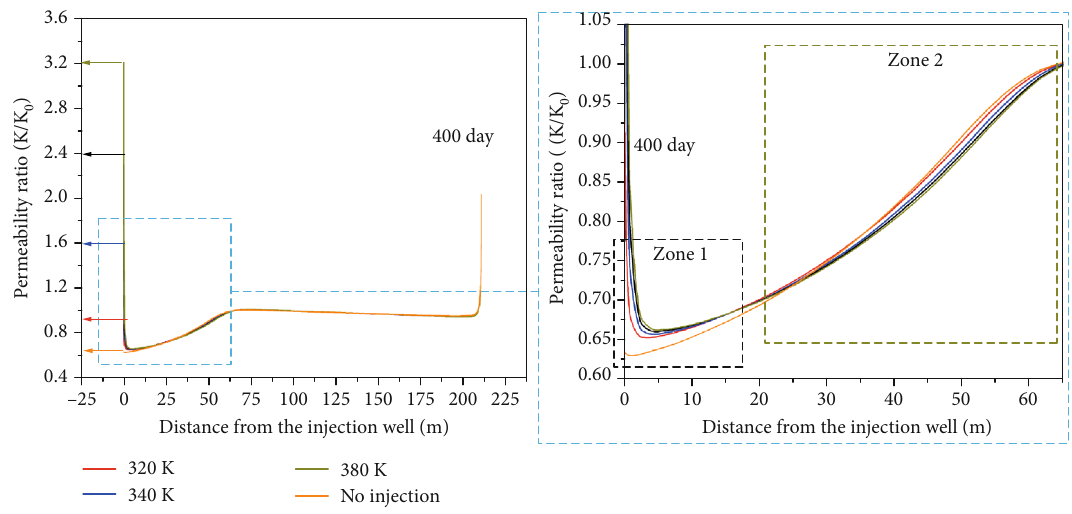
Figure 27: Evolution of permeability ratio along reference section A-B.